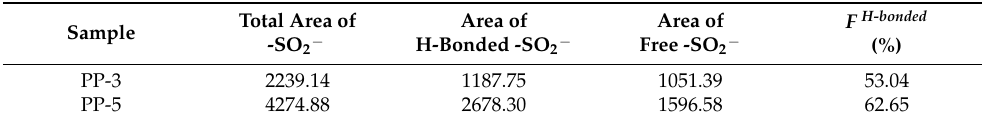
Table 4. Data from FTIR fitting integral spectra of PP-3 and PP-5